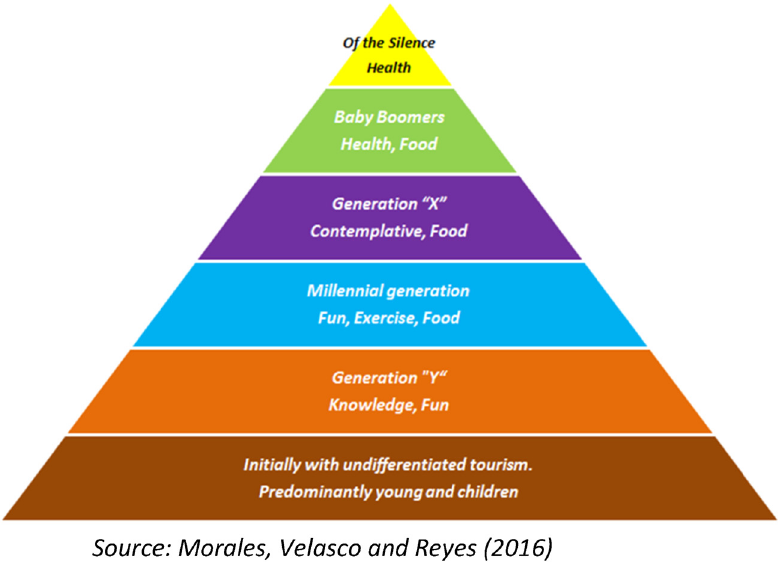
Figure 4: Segmented market of potential demand based on generational attributes. Source: Morales - Zamorano et al. ( 2016 )